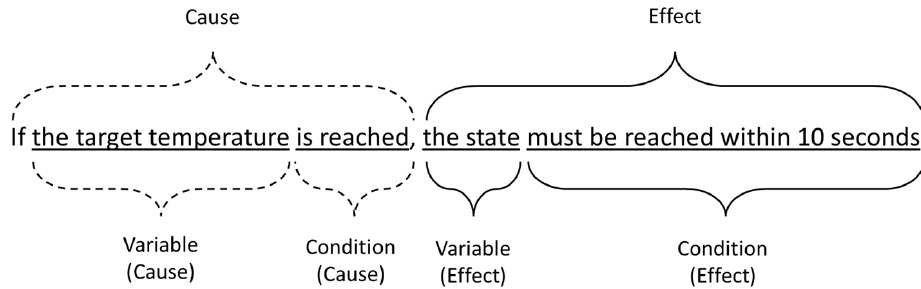
Figure 1. Formulation and building blocks.